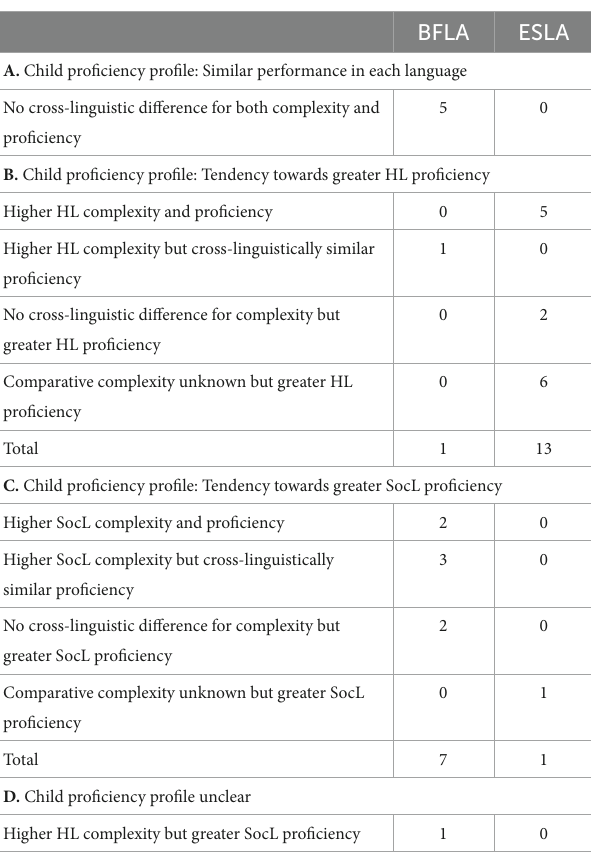
TABLE 8 Relative complexity and relative overall proficiency ratings combined (child level) *